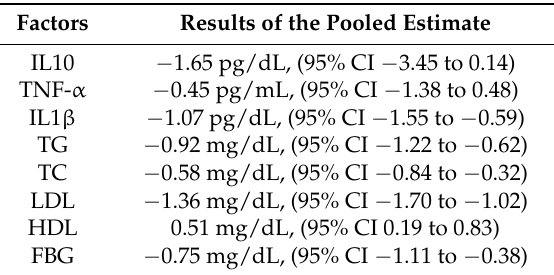
Table 2. Effect of probiotic administration on the other inflammatory, anti-inflammatory, lipid profile and glycemia measurements.